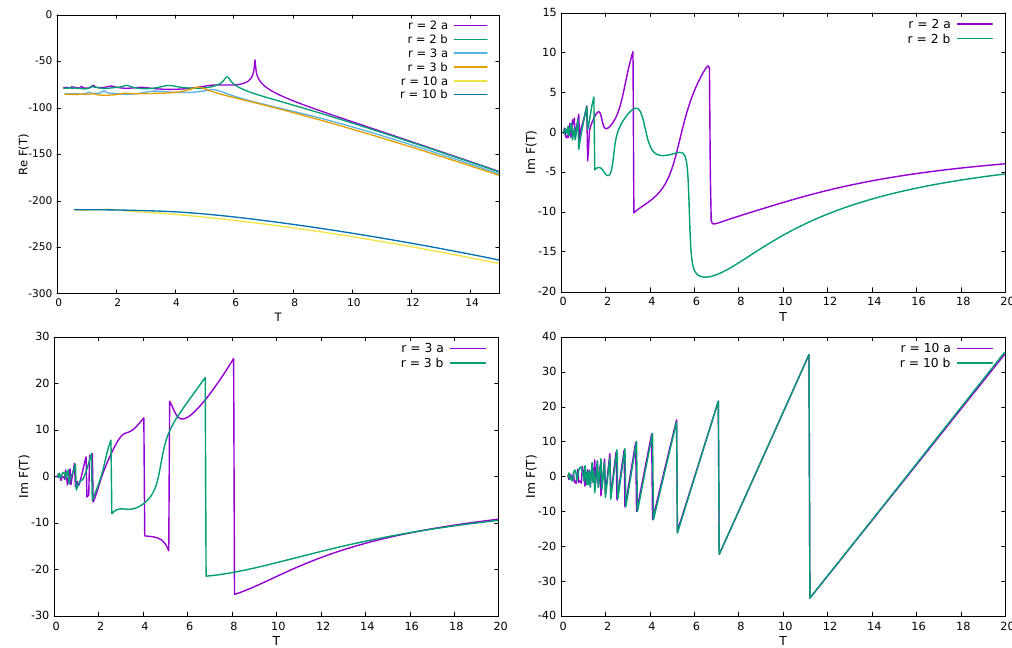
Figure 14: Free energy for N = 34, two different disorder realizations ( a , b ), θ = π/ 6 and different r ’s. Top left is the real part. The rest correspond to the imaginary part. In all cases, results for the two different disorder realizations are qualitatively similar. As r increases, the dependence on the specific choice of random couplings become